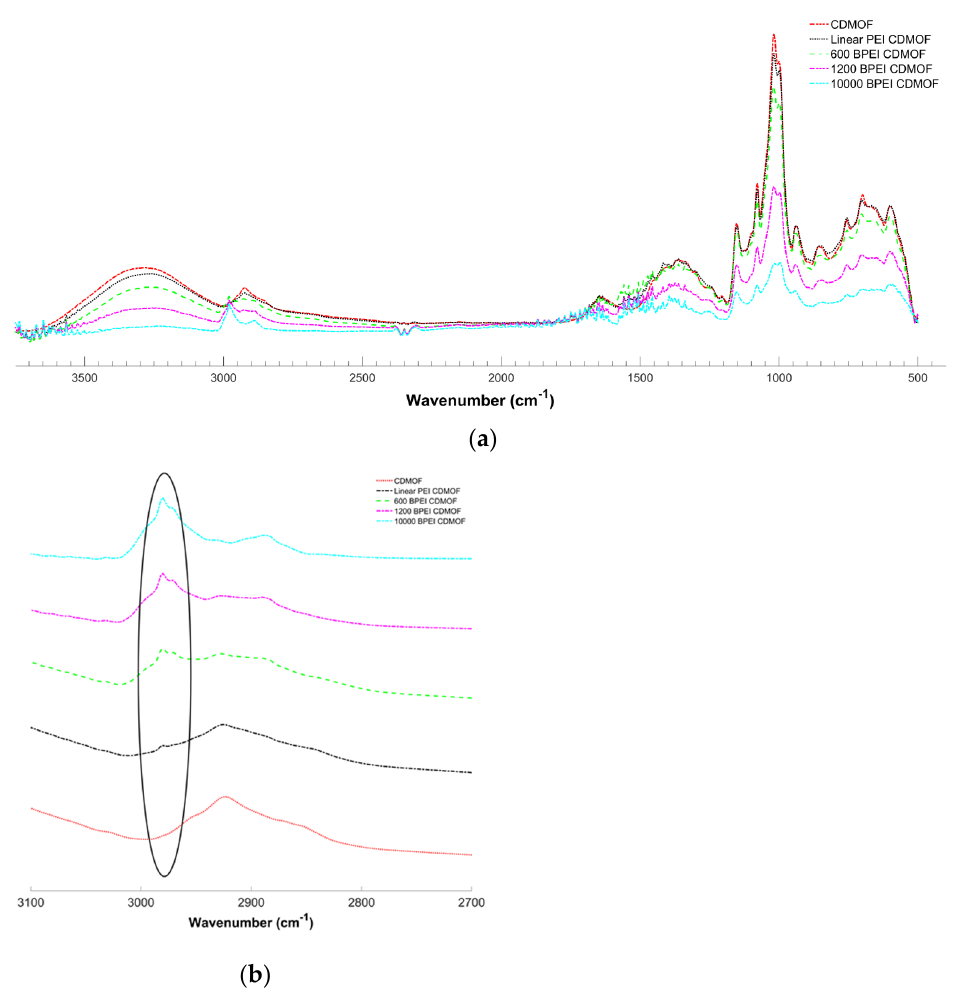
Figure 5. FTIR spectra of control and PEI loaded γ -CD-MOFs, ( a ) entire spectra and ( b ) the region of 2800–3100 cm − 1 wavenumber on the FTIR spectra to clearly capture the details of this range .